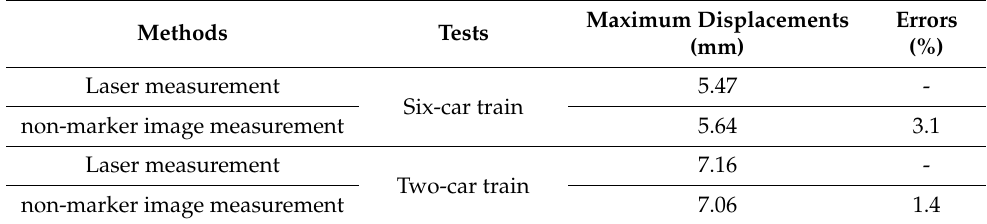
Table 9. Maximum displacements of bridge A.